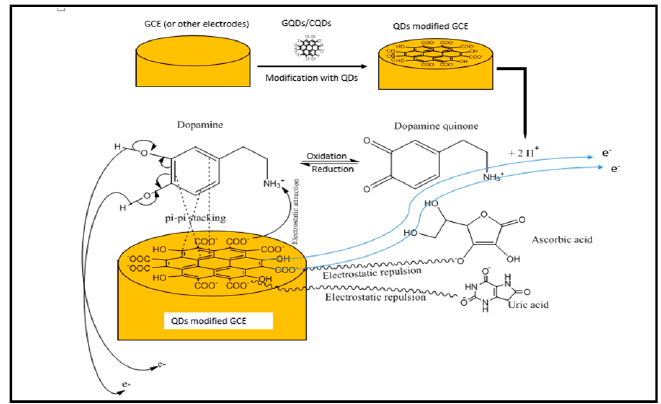
Figure 14. Mechanism for the selective dopamine determination in the presence of AA and UA at physiological pH (taking modified GCE as standard).